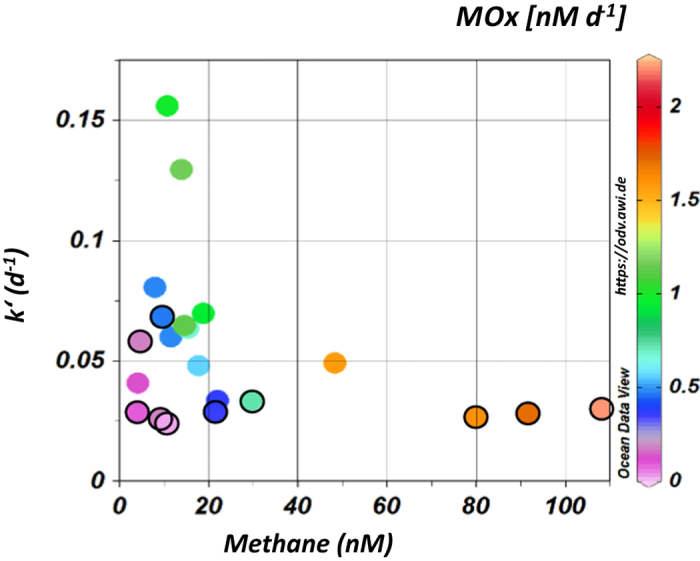
The relative activity of methane oxidizing microorganisms (k′) versus methane concentrations at Hornsundbanken (encircled) and Isfjordenbanken (without outline).The color code shows the resulting methane oxidation rates (MOx). Highest MOx-rates correlate with sites of gas emissions, i.e. highest methane concentrations. In addition, k′ and MOx increase down-current from Hornsundbanken to Isfjordenbanken. The plot was generated using Ocean Data View Version 4.5.7 (https://odv.awi.de).